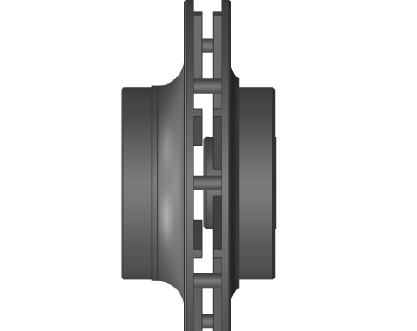
Figure 2. Present tesla bladed disk (TBD) impeller (the flow direction can be seen in Figure 3).